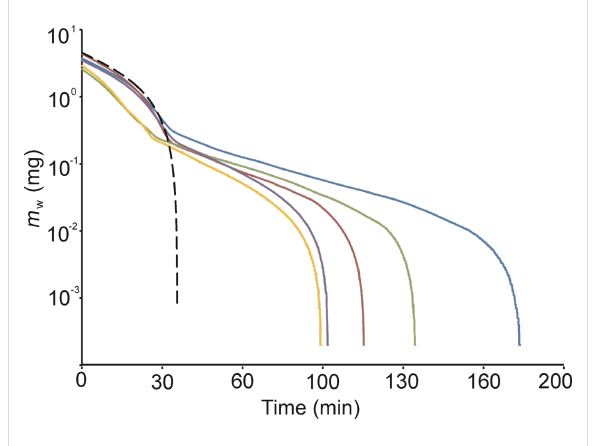
Figure 2: Desiccation dynamics of five individual plantain seeds (solid lines) and a water droplet (dashed line). m w is mass of absorbed water or a water droplet mass. The first 30 min of desiccation of the water droplet and mucilage are comparable. After about 35–40 min the mucilage lost about 91% of the water while the water droplet complete- ly